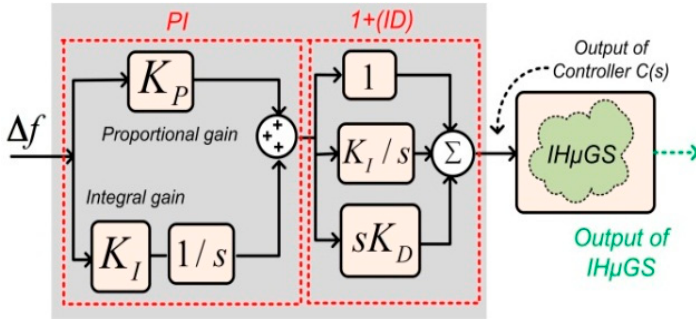
Figure 3. Proposed PI-(1+ID) controller. Figure 3. Proposed ( PI − (1 + ID) ) controller.